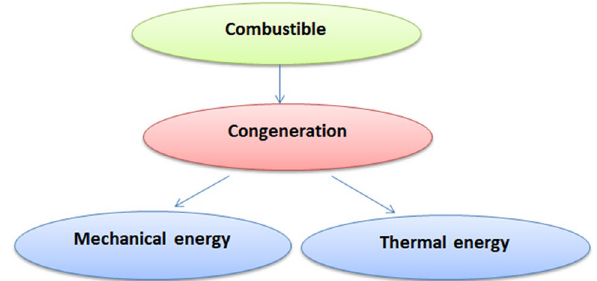
Fig. 5 Diagram of a cogeneration